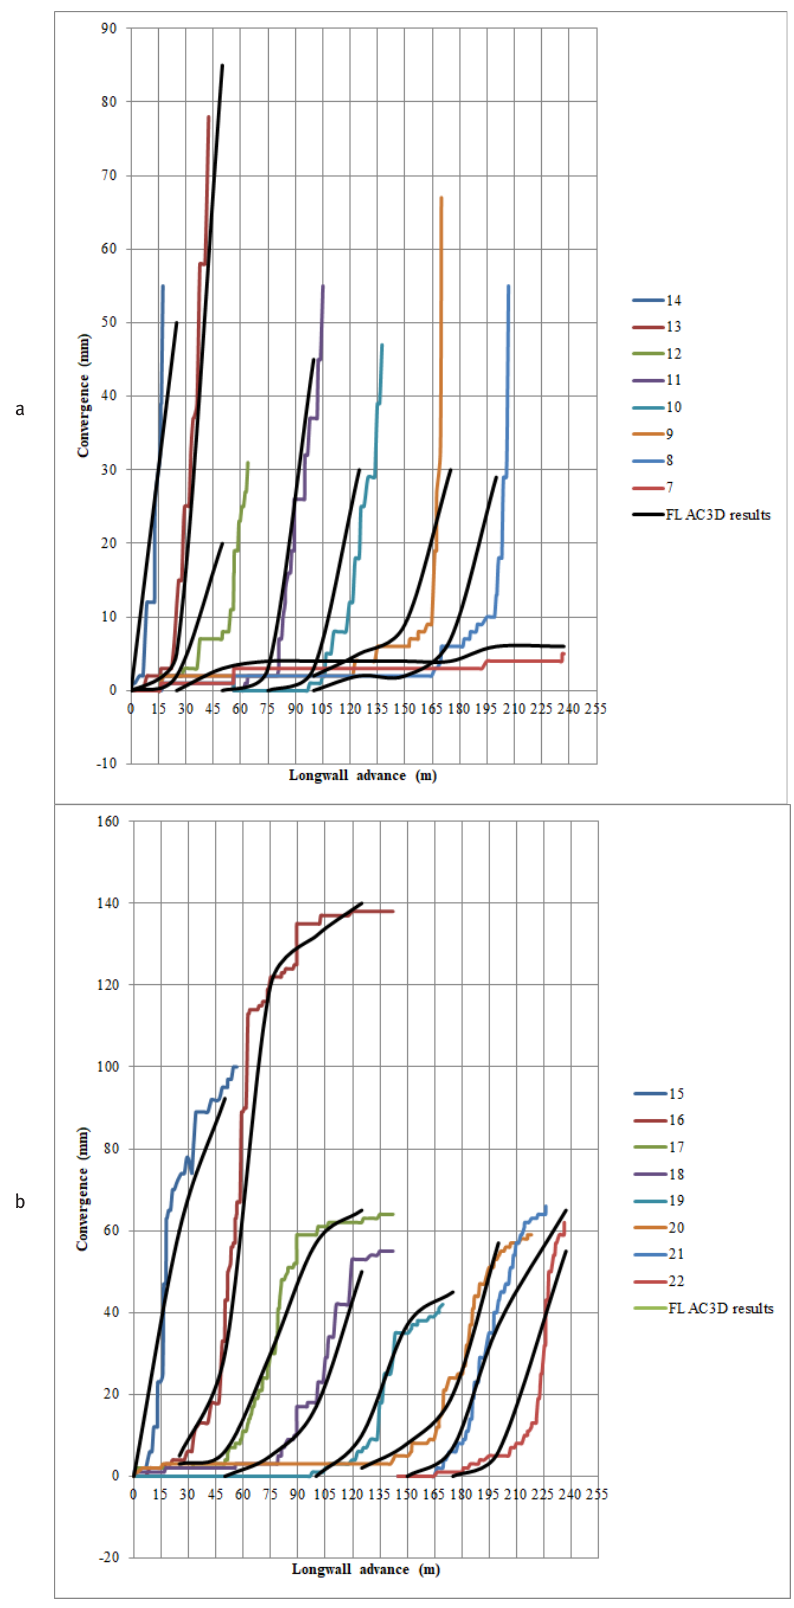
Figure 12: Progress of vertical convergence at: a) headgate, b)